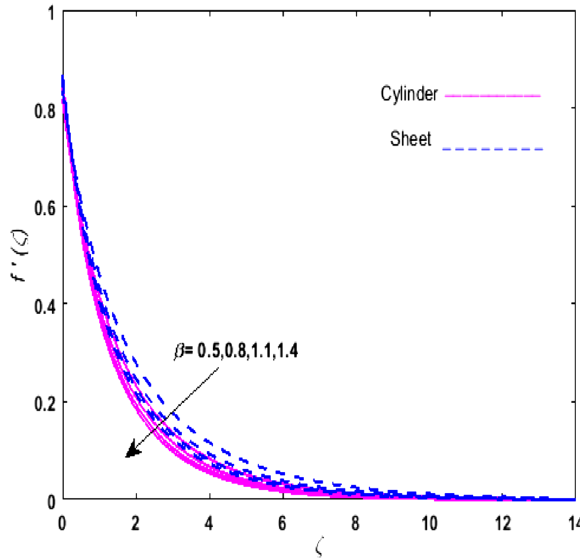
Figure 2. Upshot of β on f ′ (ζ) .